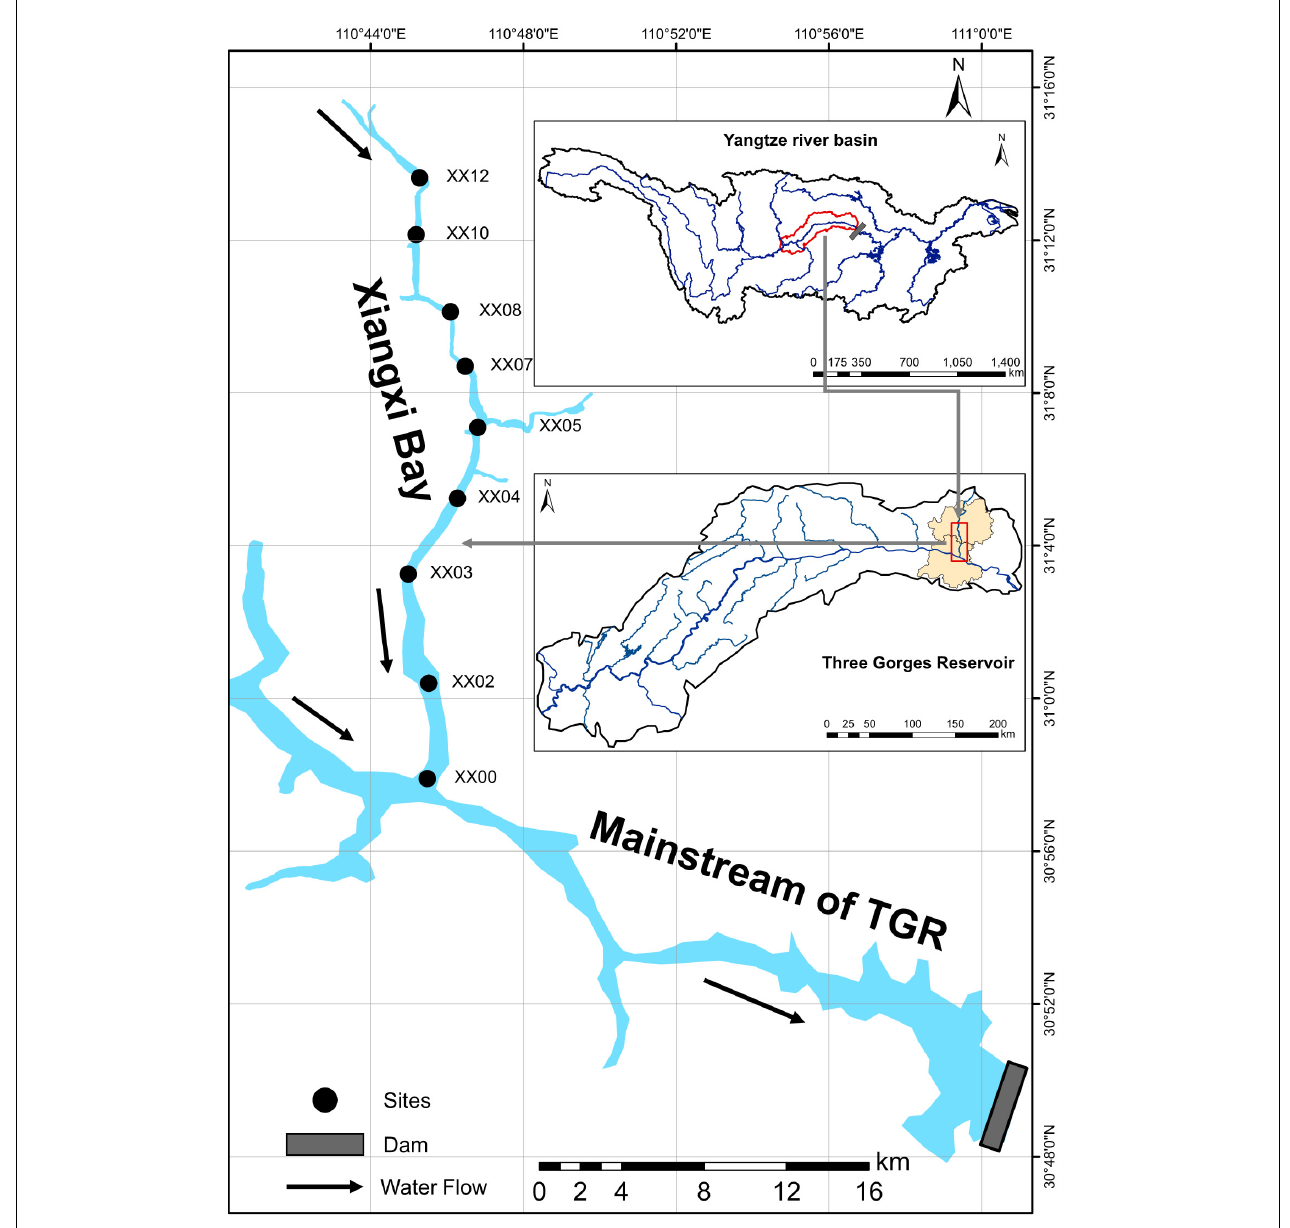
FIGURE 1 | Spatial distribution of the sampling sites in the Xiangxi Bay of Three Gorges Reservoir. Arrows in the figure represent the direction of water flow. This map was created by QGIS (Ver. 3.20.3,